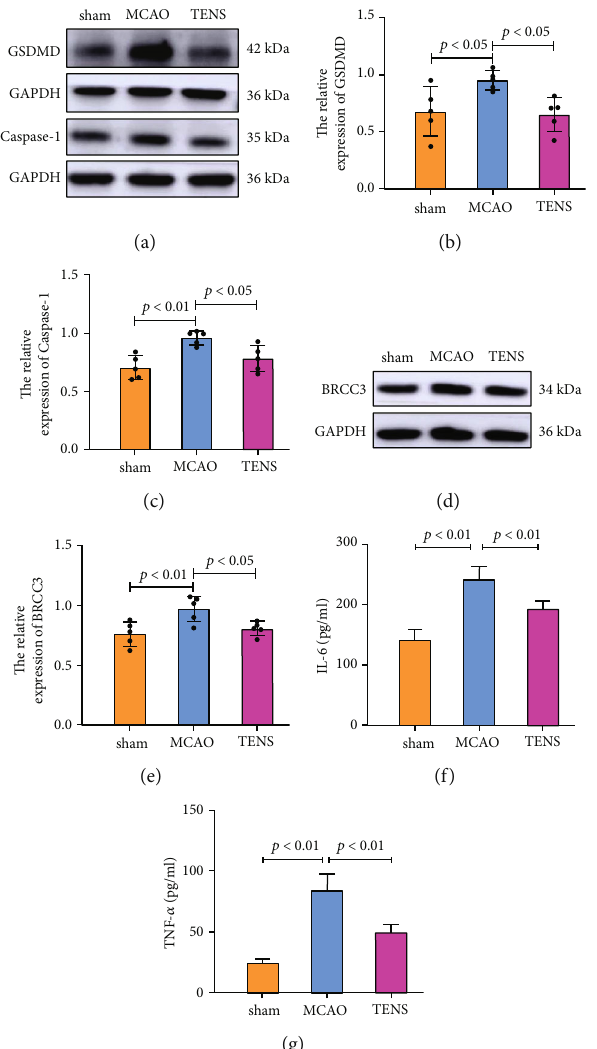
Figure 5: The e ff ect of TENS treatment on neuroin fl ammation-related proteins. (a, d) The GSDMD, caspase-1, and BRCC3 expressions were detected by western blot. (b, c, e) Statistical analysis showing the expression di ff erence of GSDMD, caspase-1, and BRCC3 in the injured hippocampus among three groups. (f, g) Statistical analysis of the levels of IL-6 and TNF- α assessed by ELISA